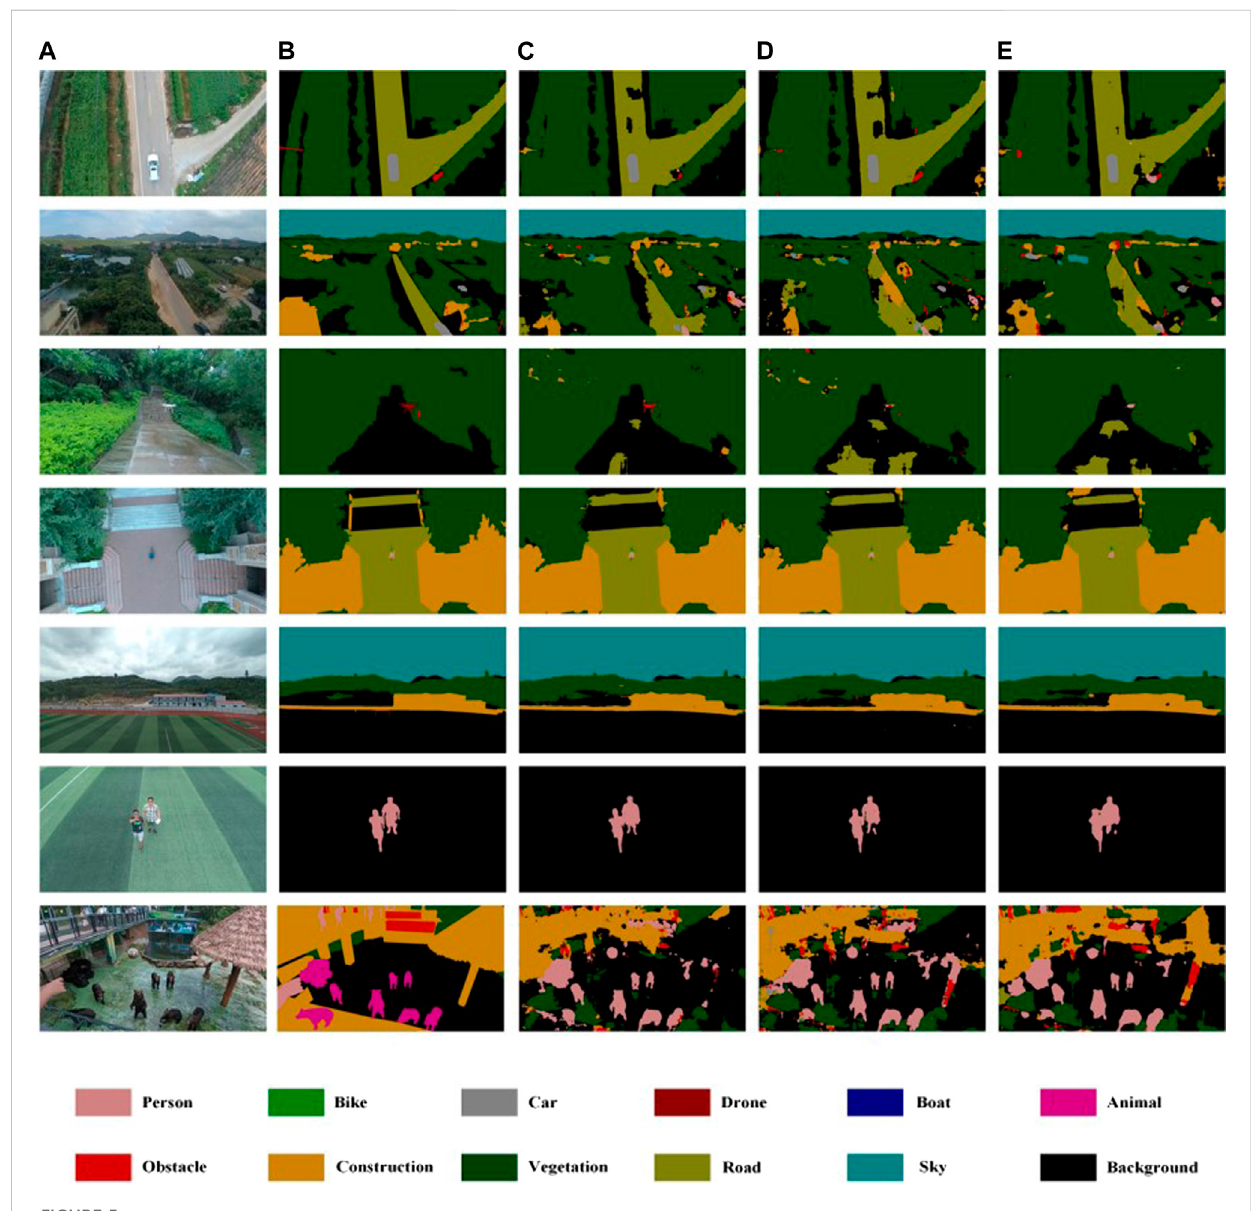
FIGURE 5 Semantic segmentation results in the AeroScapes dataset with FCN-8s, FCN-16s, and FCN-32s, respectively. Different colors represent different labels. (A) Image; (B) Label; (C) FCN-8s; (D) FCN-16s; (E) FCN-32s.